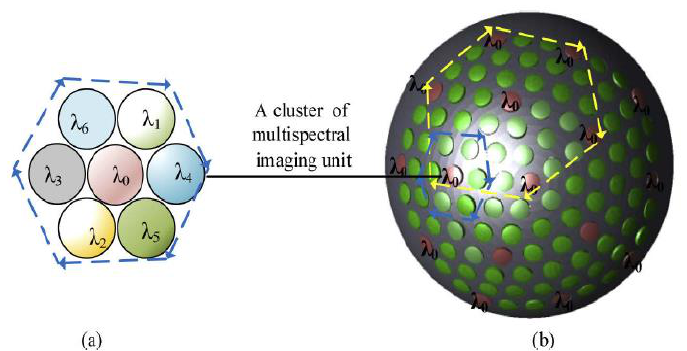
Figure 47. Multispectral channel layout for MCCEC. ( a ) Layout for a cluster of microlenses with seven spectrum channels. ( b ) Layout for a whole curved compound eye.